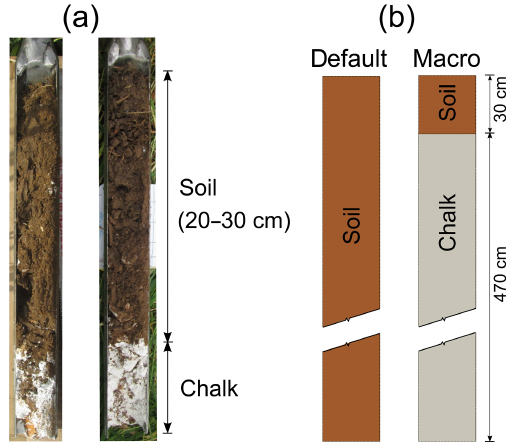
Figure 2. (a) Example of soil profiles collected at Warren Farm dur- ing a field campaign in 2015 and (b) the two model configurations.